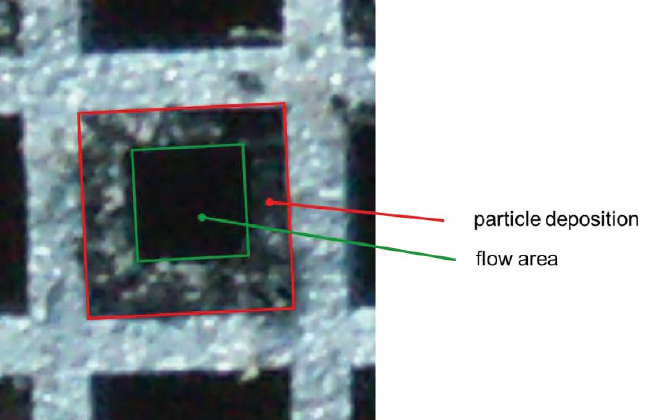
Figure 9: Reduction of flow area by particle deposition in a square-shaped